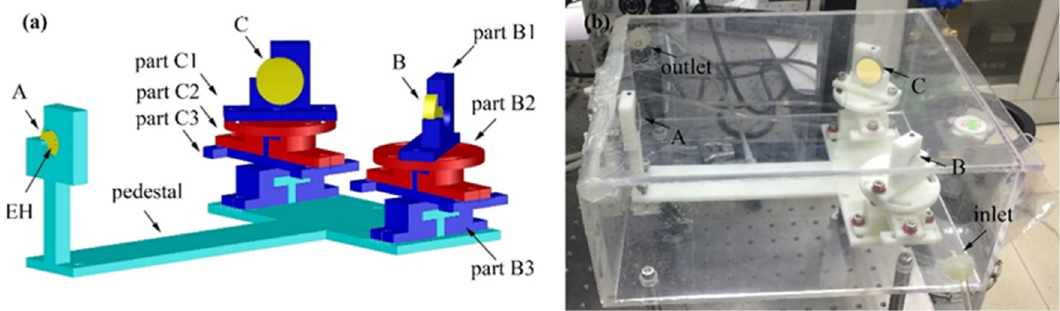
Figure 6. ( a ) A 3D model of the mechanical adjusting structure. ( b ) A photo of the developed gas cell for gas detection with a gas inlet and an